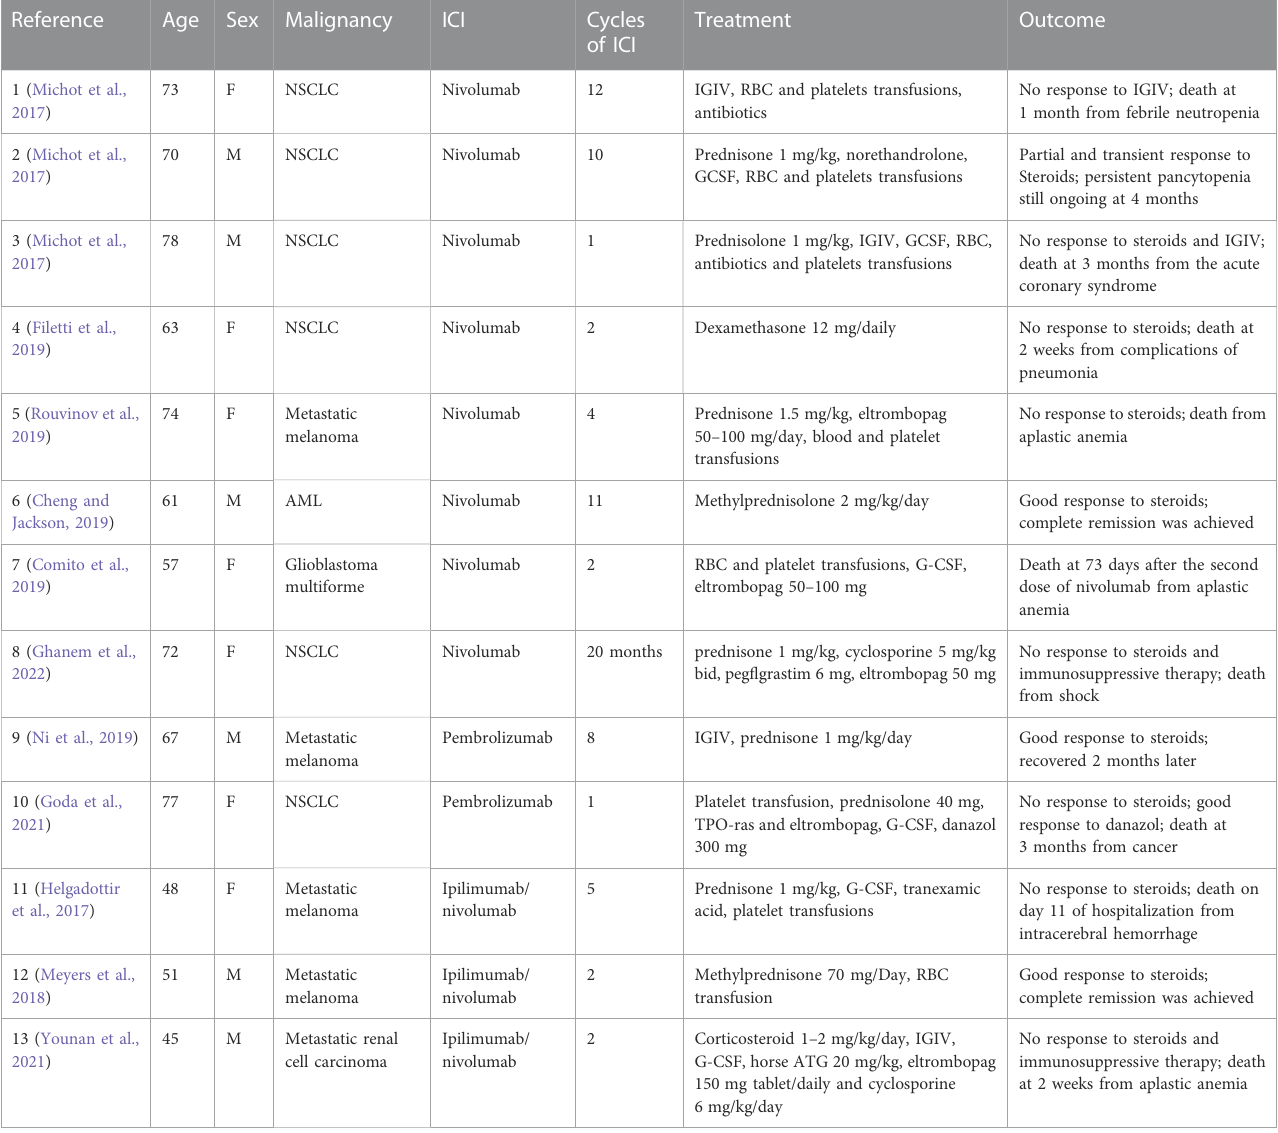
TABLE 2 Summary of case reports of immune checkpoint inhibitor-induced aplastic anaemia reported in the literature.